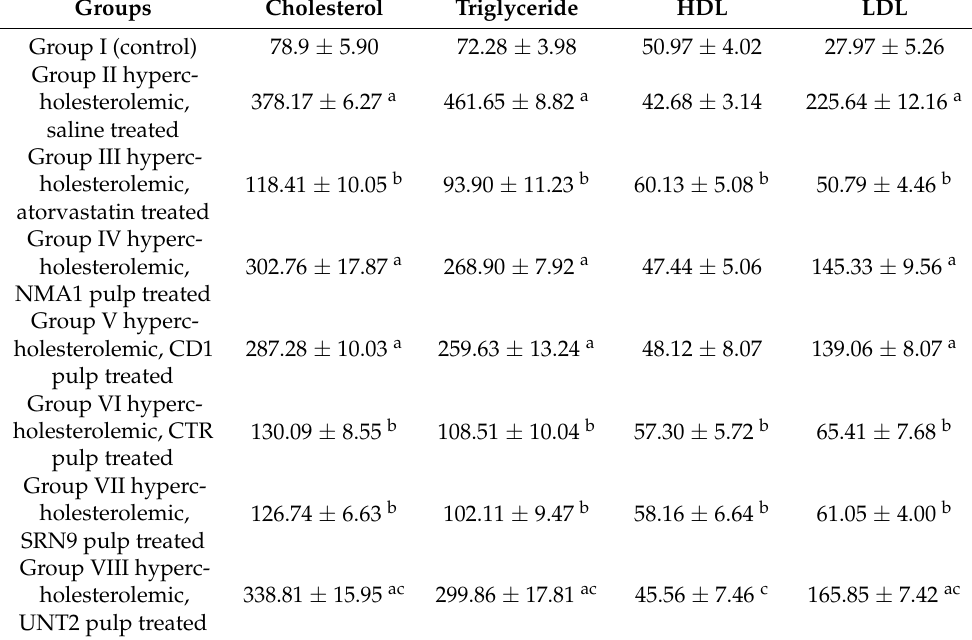
Values represent the mean ± SD for observations made on six rats in each group. Units: milligrams per deciliter. a Statistically significant difference ( p < 0.05) when compared with group I values, b Statistically significant difference ( p < 0.05) when compared with group II values, c Statistically significant difference ( p < 0.05) when compared with group III